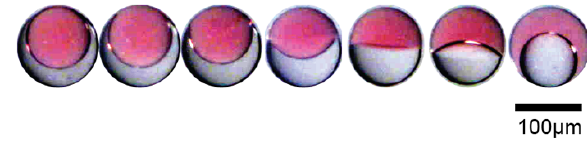
Fig. 1. Side view optical micrographs of droplets composed of FC-770 (grey) and heptane (red) with varying internal interface curvature. The red color of the heptane phase results from the incorporation of a Rhodamine-based